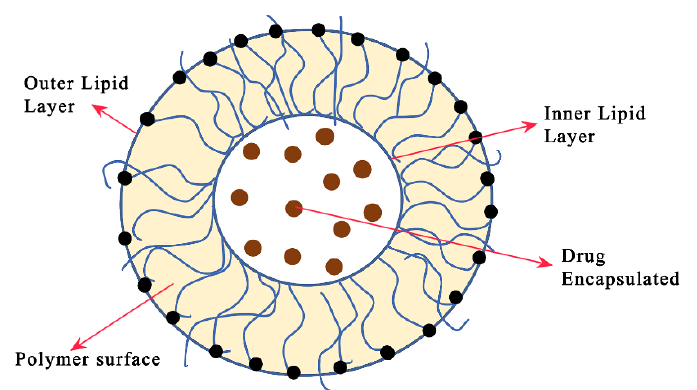
Figure 7. Illustration of a bilayer lipid-based nanocarrier with encapsulated drugs in the core; the self-assembled supramolecular architecture is shown. The solid lipid matrix encapsulates bioactive components, particularly lipophilic molecules, and releases them gradually over time. Lipid polymer nanoparticles typically have spherical particles and sizes in the range of 10 to 1000 nm. There are several forms of lipid-based nanocarriers (liposomes and niosomes) reported in reference [81] for drug delivery.